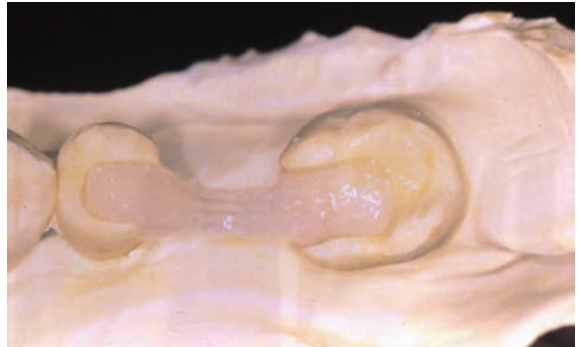
Figure 5- The finished restoration placed in the cast to test the